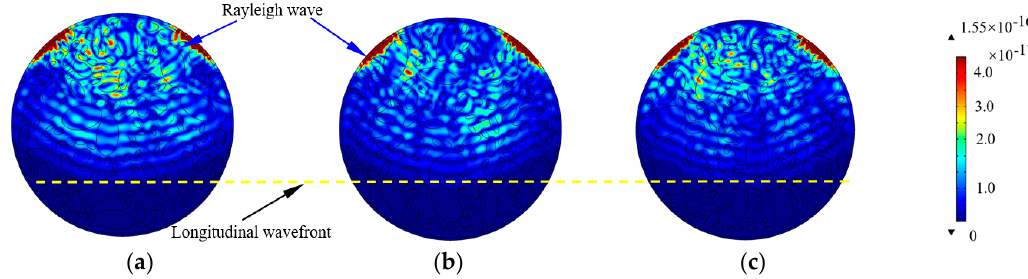
Figure 6. Comparison of the stress wave fields considering the aggregates distribution. ( a ) Elliptical sample 1; ( b ) Elliptical sample 2; ( c ) Elliptical sample 3.